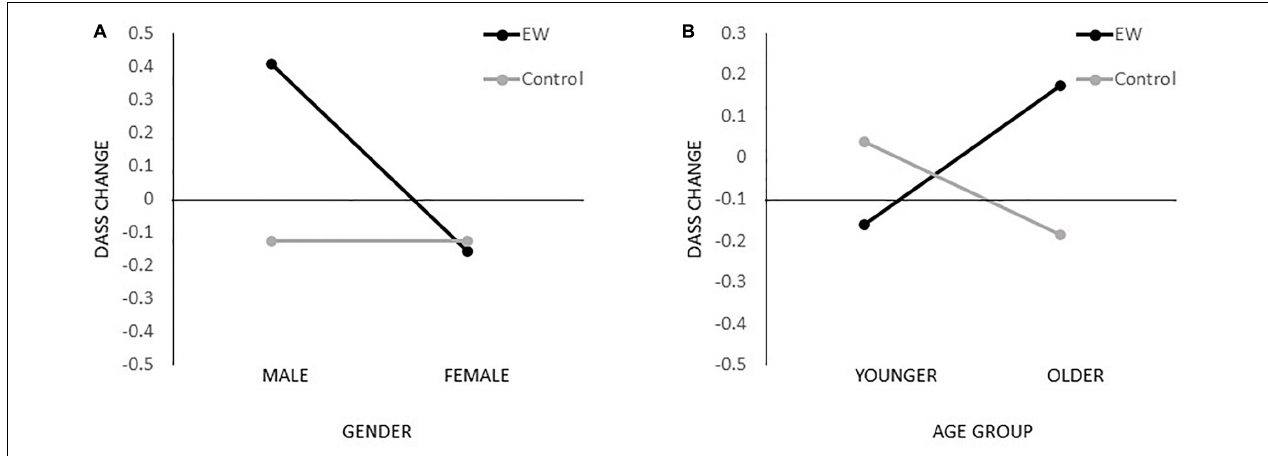
FIGURE 2 | Interaction effects on the primary outcome. Interaction effects gender × treatment group (A) and age group × treatment group (B) for the primary outcome change score (DASSchange = DASSpost – DASSpre); positive values indicate elevated symptoms while negative values indicate reduced